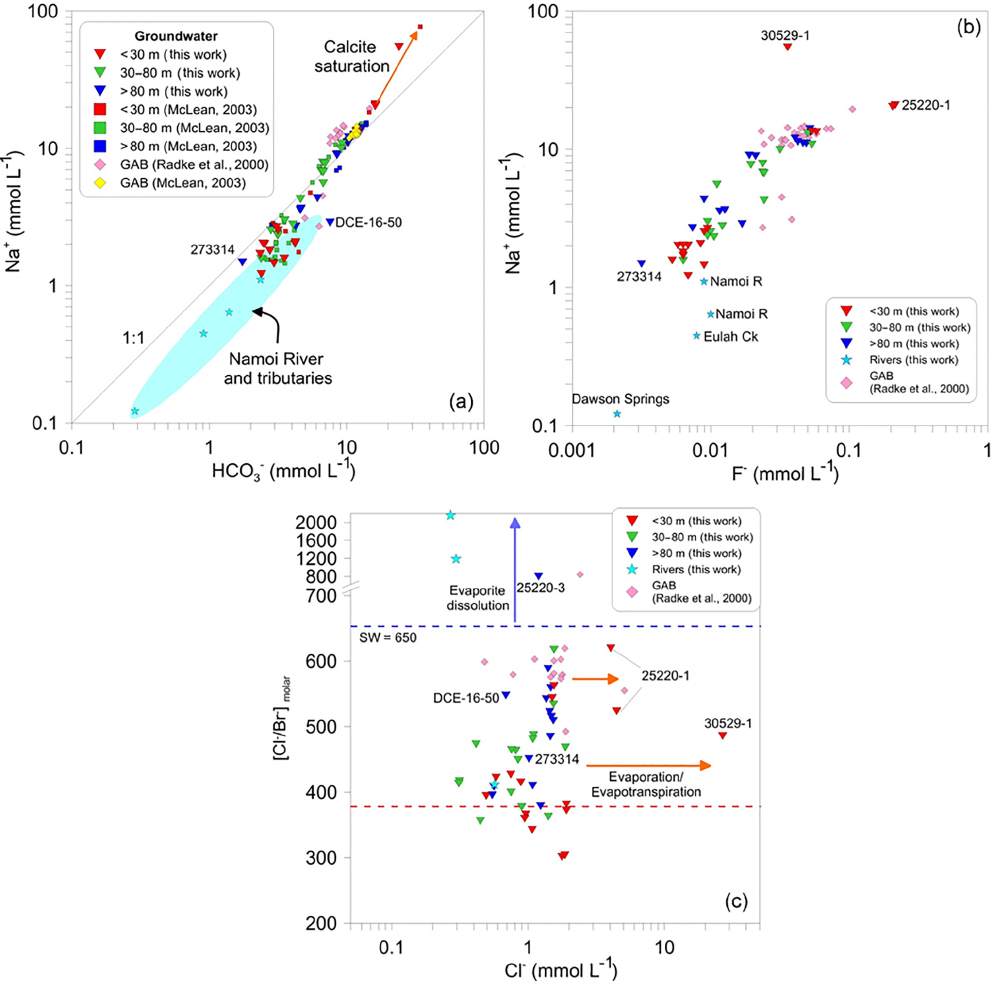
Figure 3. (a) Na + vs. HCO − showing the mixing trend that the alluvial samples form between the Namoi River and samples from the 3 GAB (Radke et al., 2000; McLean, 2003). The orange calcite saturation line indicates samples that are more enriched due to separate evapotranspiration and calcite precipitation. The shaded blue ellipse represents all river chemistry data available for the Namoi River and tributaries (this work, n = 4; McLean, 2003, n = 4; Mawhinney, 2011, n = 79). (b) Na + vs. F − and (c) Cl − / Br − vs. Cl − , highlighting the mixing trend between the surface recharge and the GAB that we observe in other geochemical indicators. The red dotted line represents the Cl − / Br − ratio for rainfall and the blue dotted line is the seawater